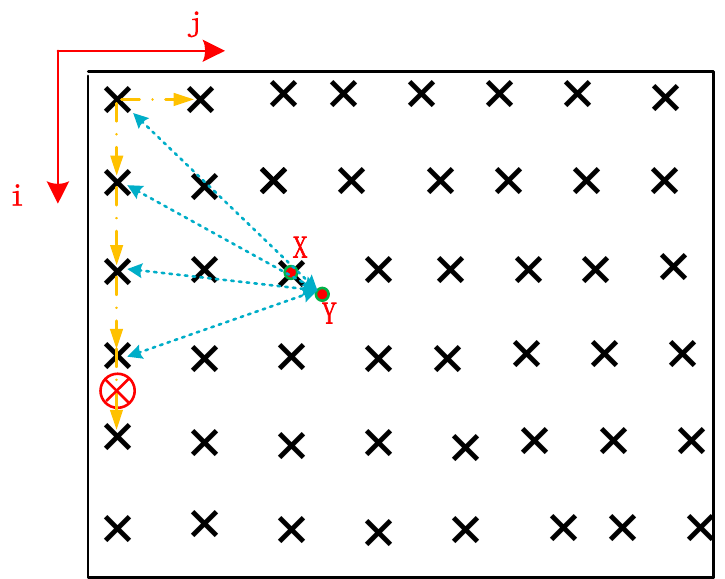
Figure 4. Schematic diagram of ambiguity search optimization algorithm.